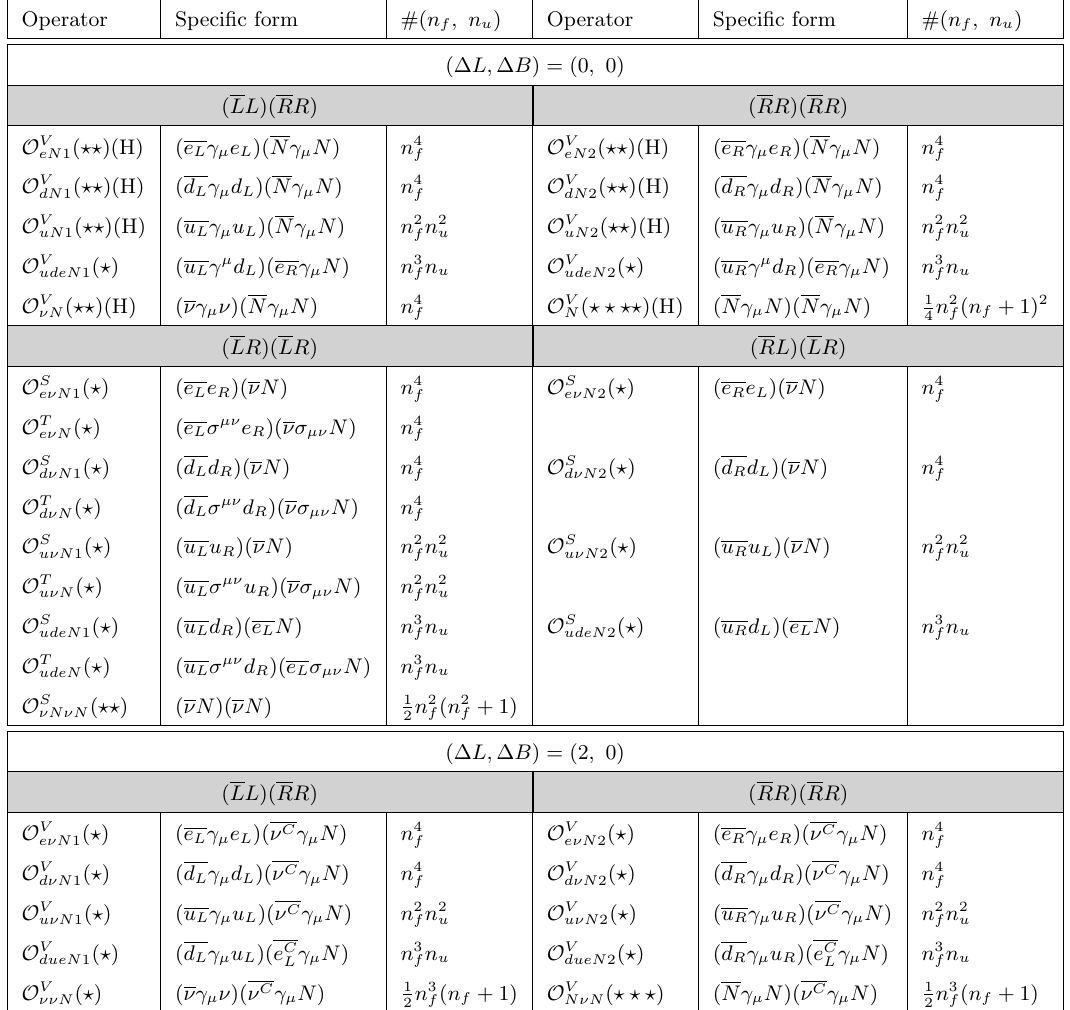
Table 6 . Dim-6 operator basis involving RH neutrinos N in LNEFT. Here all operators are non- hermitian expect those with a (H) in the (cid:12)rst sector. The number of ? after each operator indicates the number of the RH neutrinos involved in the same